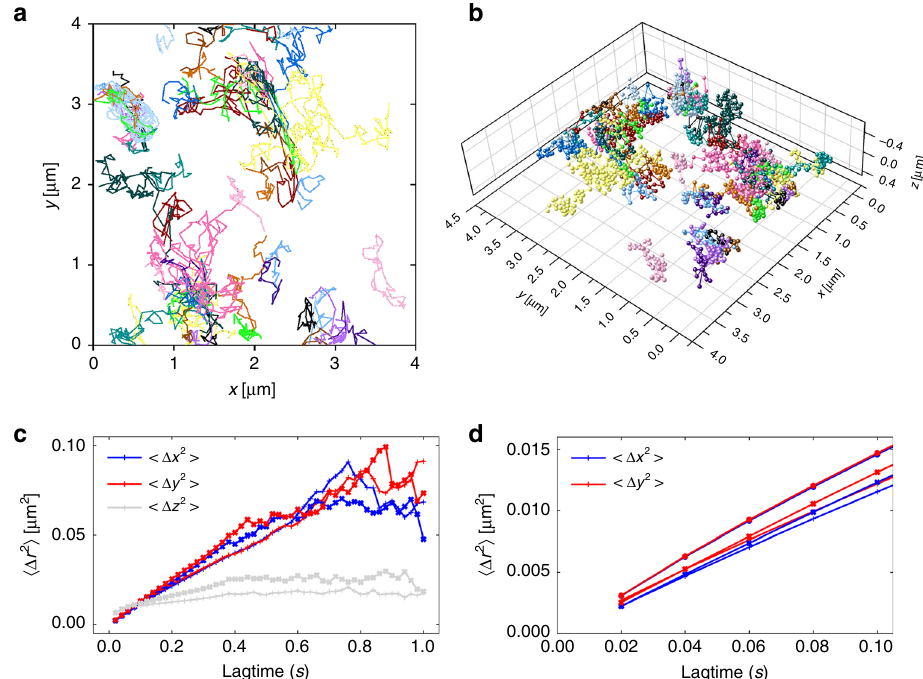
Fig. 2 Single-particle tracking in living cells by LLSM. a Trajectories of CD56 molecules in the plasma membrane of 293T cells measured at 37 °C. b Astigmatic detection enables tracking of CD56 receptors in 3D. c The ensemble mean square displacement for each dimension r 2 ( x , y , z ) for all trajectories with (cross symbols) and without (plus symbols) actin inhibitor CK666. n = 7 different cells were tracked for each condition. Each cell yielded an ensemble of >100 trajectories. d Ensemble mean square displacement zoomed to the part from which diffusion constants were determined by fi tting a linear function. In addition to the LLS microscopy data ( n = 7 tracking experiments examined from different cells of one biological sample), 2D-TIRF data are shown for 293T cells ( n = 6 tracking experiments examined from different cells of one biological sample) adhered on cleaned coverslips (circle